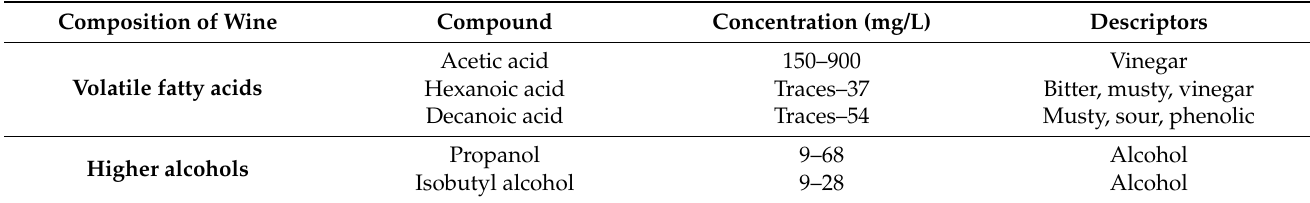
Table 1. Volatile acids and higher alcohols of wine [11].